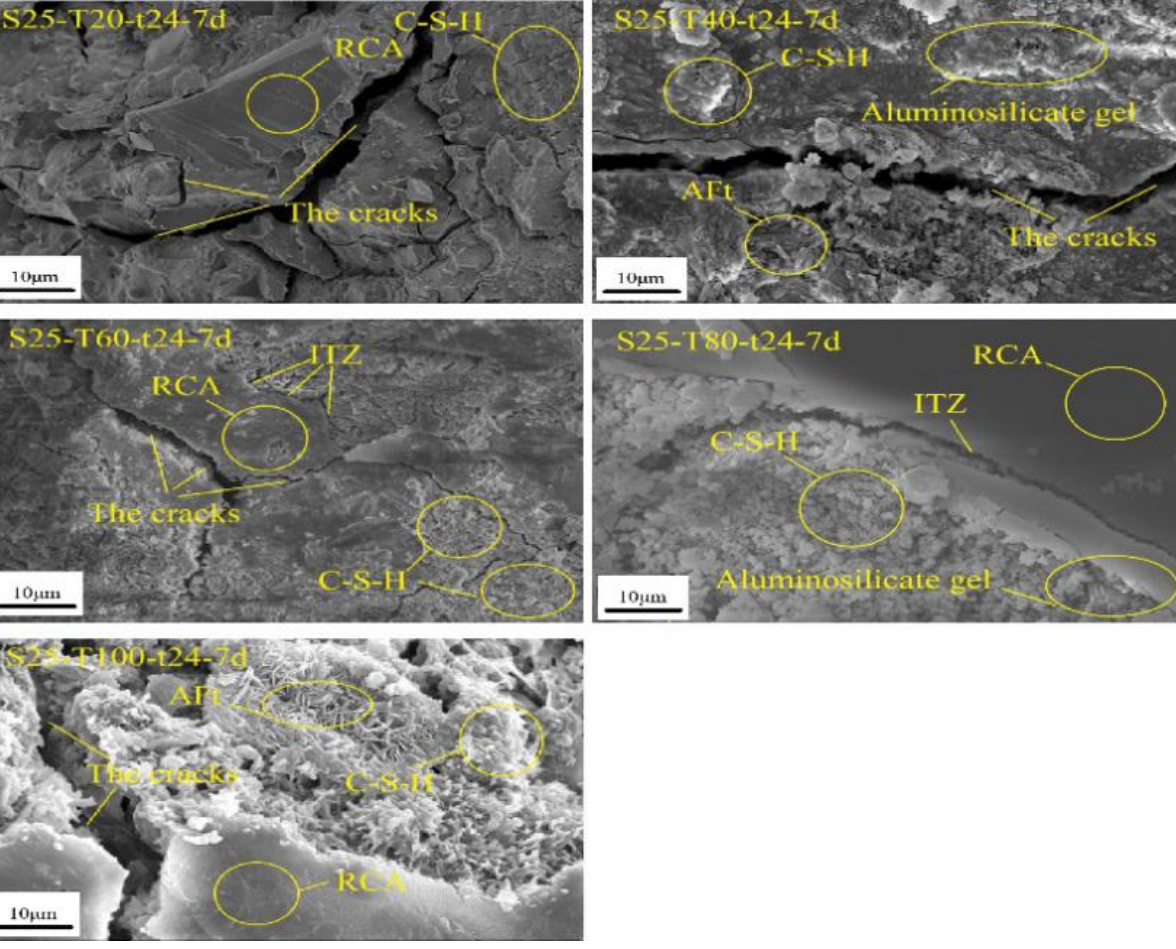
Figure 10: Microstructure at 80 ∘ C curing temperature